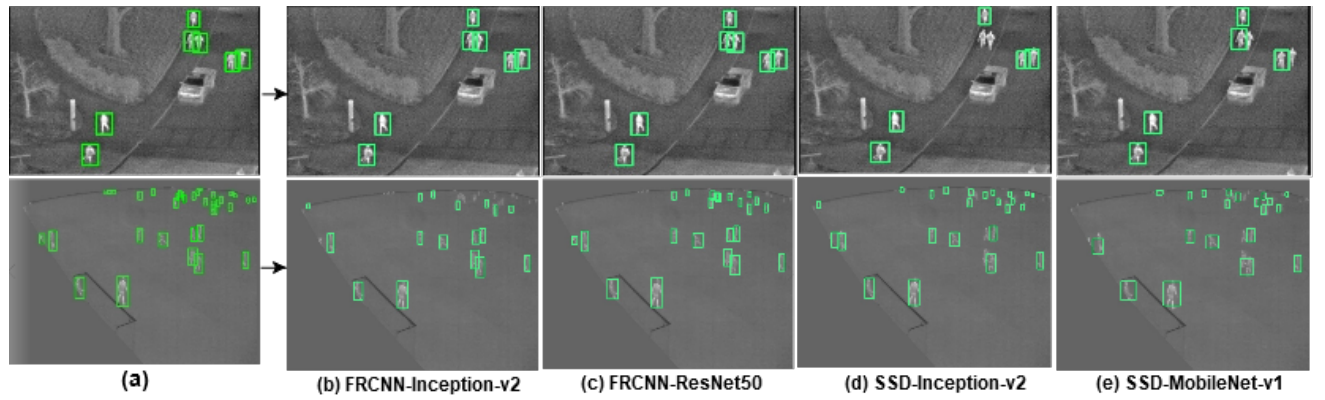
Figure 8. Qualitative results of various models ( a ) ground truth ( b – e )